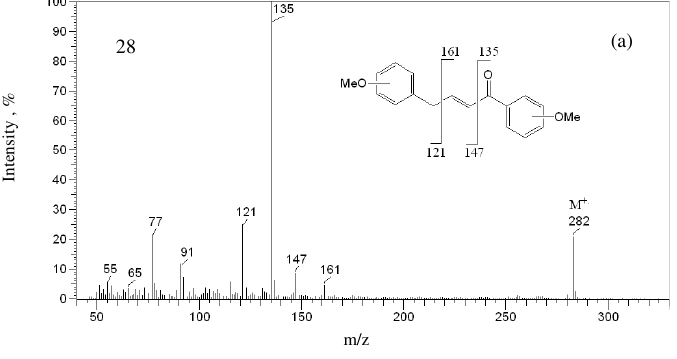
Figure 3 . Spectra, structures and important fragments of 14-( x -methoxyphenyl)-1-phenyl-1- butanone ( 21 ) and 2,6-dimethoxybenzoic acid benzyl ester ( 24 ) Seven compounds, which are all 1, n -bis( x -methoxyphenyl)alkane derivatives are tentatively identified on the basis of their fragmentation patterns: 1,4-bis(x- methoxyphenyl)-but-2-en-1-one ( 28 ), 1,5-bis ( x -methoxyphenyl)- pent-3-en-1-one ( 33 ), 1,4-bis ( x -methoxyphenyl)-1-pentanone ( 34 ), 1,6-bis( x -methoxyphenyl)-3-heptene ( 35 ), 1,6-bis( x -methoxyphenyl)-hex-2(3 or 4)-en-1-one ( 36 ) and 2(3, 4 or 5)-hydroxy-1,6- bis(x-methoxyphenyl)-1-hexanone ( 37 and 38 ). It is probable that the methoxy- substituents of these compounds are in the para- position but, in the absence of authentic standards this cannot be ascertained. These are all new compounds hitherto not reported in the chemical literature. Their mass spectra and formation of diagnostic fragments are shown in Figure